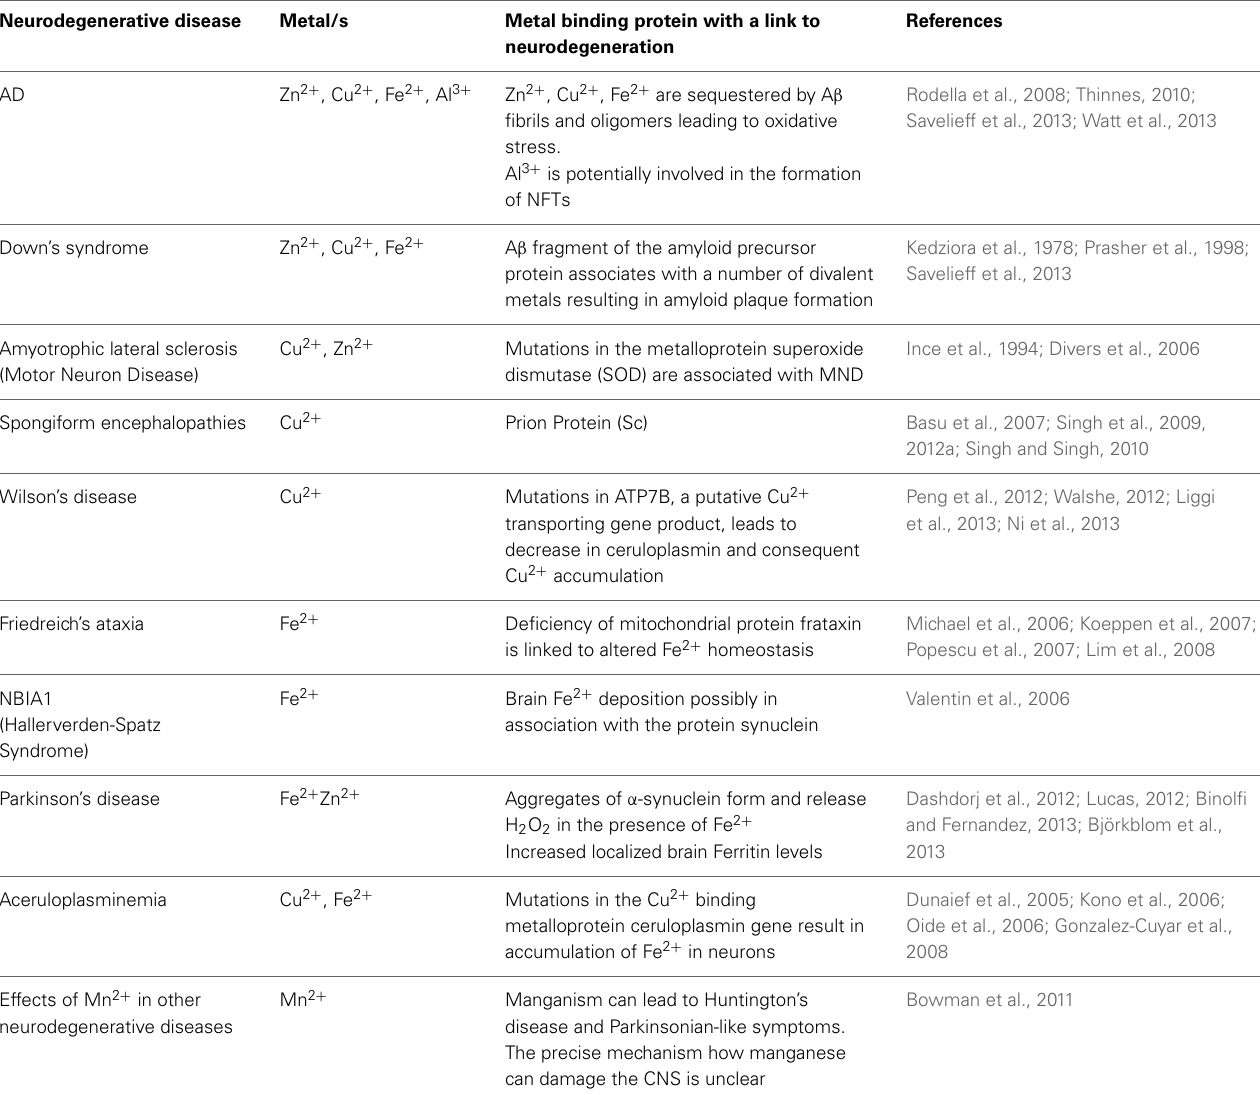
Table 1 | Metal Protein Interactions in Neurodegenerative